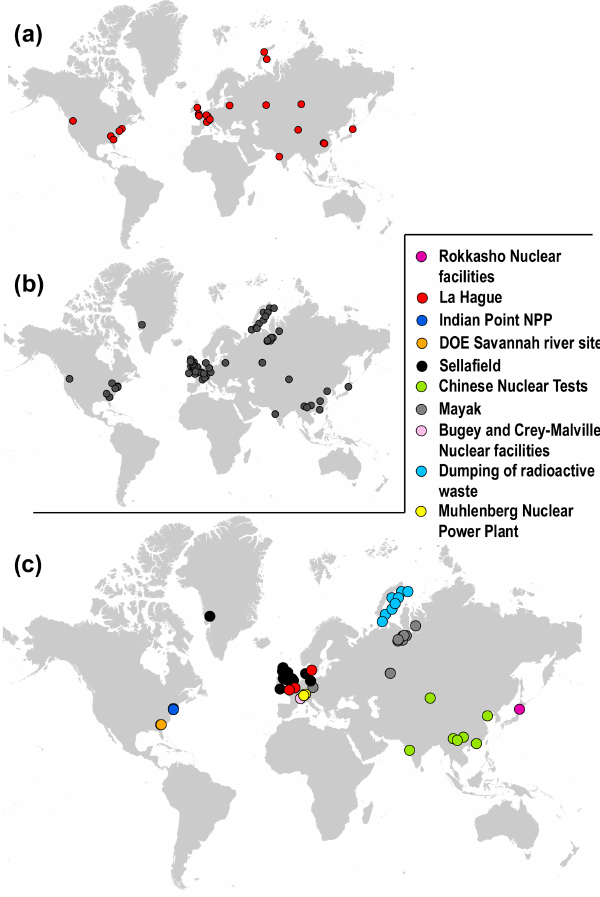
Figure 5. 137 Cs activity levels attributed to local and regional ra- dioactive releases. (a) Local and regional sources identified in the literature. (b) Releases associated with these events detected in sedi- ment cores. (c) Some examples of events detected in sediment